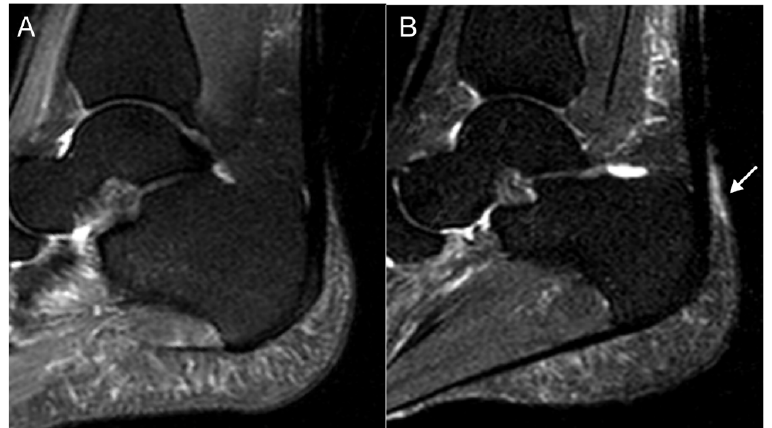
Figure 3. MRI images of a 33-year old male with psoriasis, showing a decrease in retrocalcaneal bursitis after one-year longitudinal follow-up. ( A ) T2 SPAIR weighted image showing hypersignal at the retrocalcaneal bursa consistent with mild inflammation at the bursa (arrow: grade 1; mild), ( B ) T2 SPAIR weighted image showing no hypersignal at the retrocalcaneal bursa. Figure Legend: